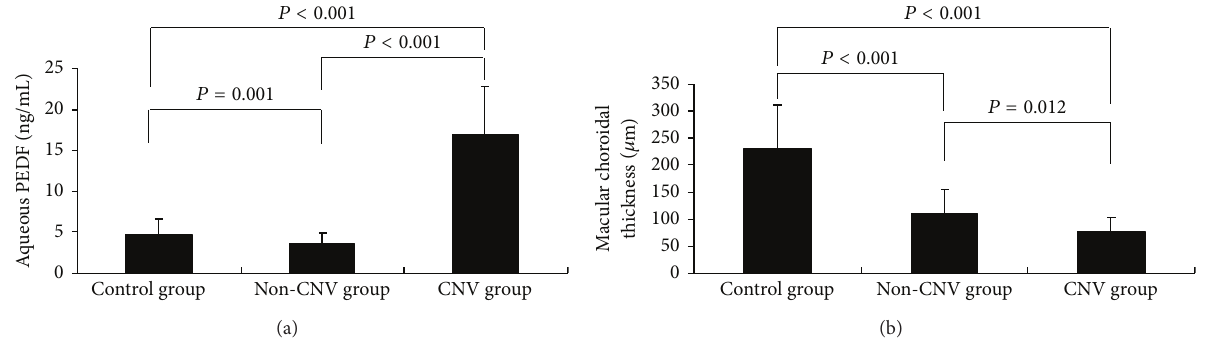
Figure 2: Aqueous pigment epithelium-derived factor (PEDF) levels in control and non-CNV groups (a) and in high myopia with CNV group. (b) Macular choroidal thickness in control, non-CNV, and CNV groups. Results are geometric mean (95% CI).